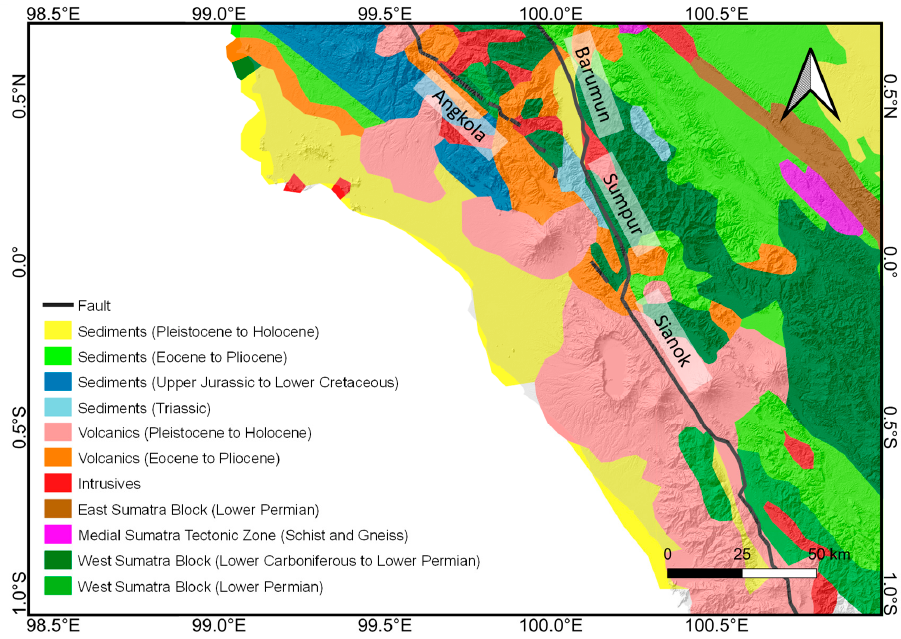
Figure 3. Geological map of Pasaman (Indonesia Geological Agency).